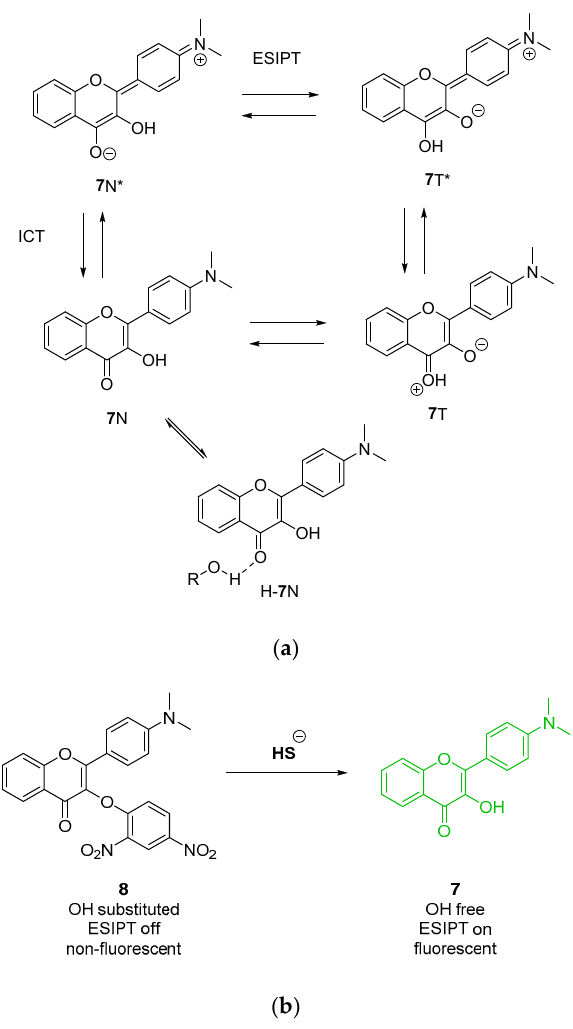
Scheme 2. Fluorescence properties of 3HF derivative 7 . ( a ) The ground and excited state forms